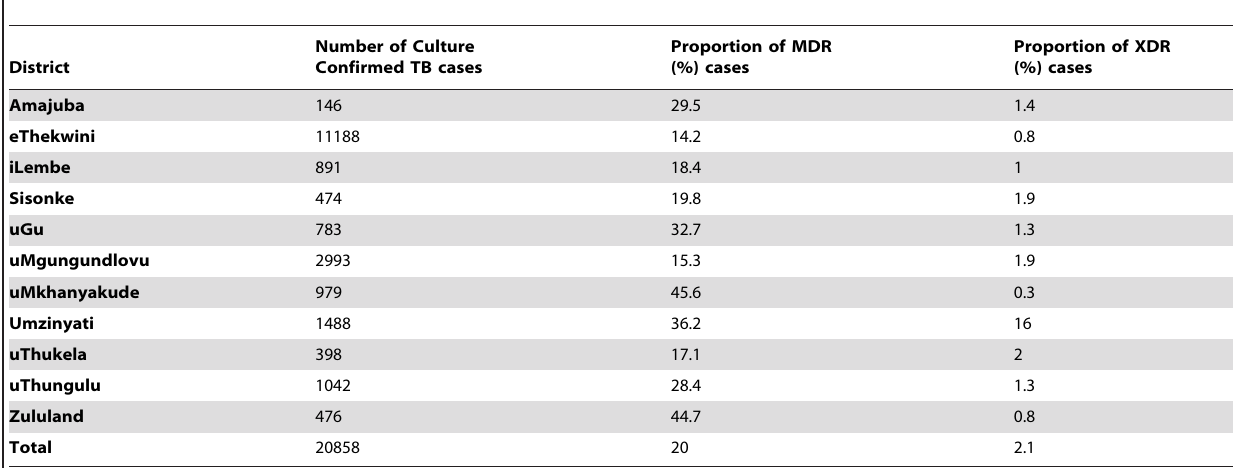
Table 2. Proportion of MDR and XDR cases of tuberculosis in the 11 health districts of KwaZulu-Natal province (as a proportion of culture-confirmed TB cases).